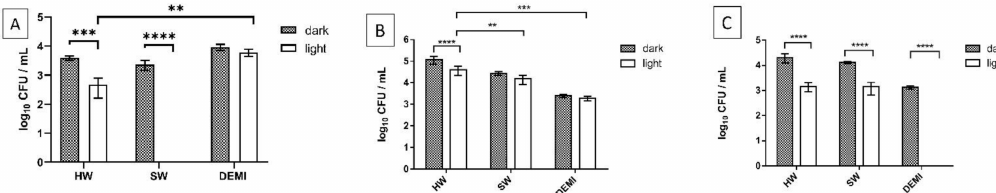
Figure 9. Impact of the PDI on adhesion of L. pneumophila to polystyrene in different water samples (DEMI, SW, HW) by using TMPyP3 ( A ), TMPyP3-CH 3 ( B ) and TMPyP3-C 17 H 35 ( C ) in concentration 0.25 × MEC determined in SW (0.782 µ M for TMPyP3-CH 3 and TMPyP3-C 17 H 35 , 1.563 µ M for TMPyP3), after irradiation for 10 min with violet light (395 nm, total light dose 12 J/cm 2 ). Treatment with PSs without irradiation was used as a “dark” control. All data are presented as mean ± SD; **** p < 0.0001, *** 0.0001 < p < 0.001, ** 0.001 < p < 0.01.